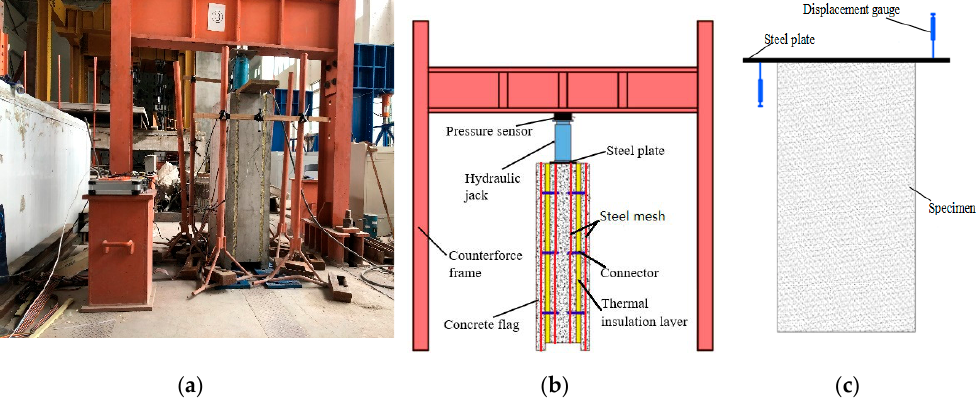
Figure 8. Schematic of loading device and measuring point. ( a ) Test layout diagram; ( b ) floor plan; ( c ) displacement gauge position diagram.